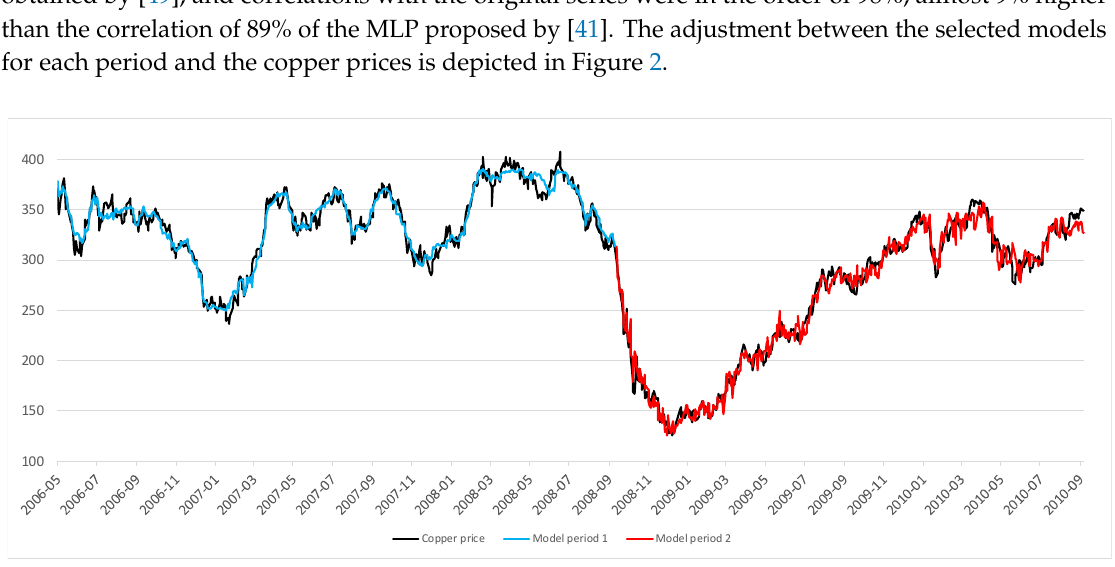
Figure 2. Comparison between the model outputs and the copper prices.